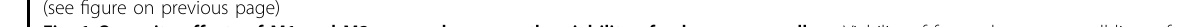
Fig. 1 Opposite effects of M1 and M2 macrophages on the viability of colon cancer cells. a Viability of four colon cancer cell lines after coculture with macrophage CM for 24 h based on the WST-1 assay. Error bars are derived from three independent experiments. b Phase contrast microscopy observation (×400) of HCT116 and HT29 cells treated with macrophage CM for 24 h. c Expression levels of SURVIVIN and BMI-1 in macrophage CM-treated HCT116 and HT29 cells based on western blotting. d Extent of caspase-3 activation and cleavage of PARP in cell lysates, as measured by western blotting. e Apoptotic cells were determined by FACS using annexin V/PI double staining after 24 h of incubation with each macrophage CM with HCT116 and HT29 cells. f The colony formation effect of each macrophage CM on HT29 cells. Representative images of the colony-forming assay (upper panel) and analysis of colony formation rates (lower panel) are shown. The results are presented as the mean value ± SE. * P < 0.05; ** P < 0.01; *** P <